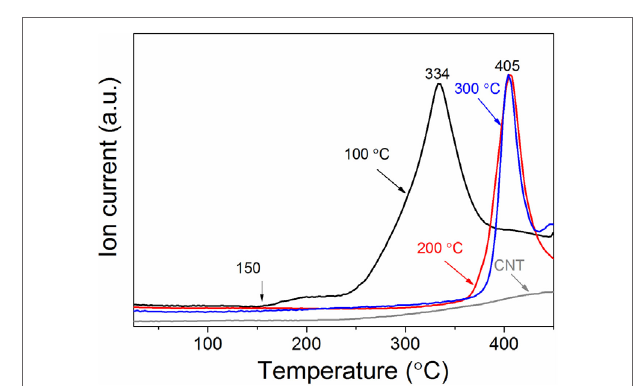
FigUre 3 | X-ray diffraction (XRD) of the magnesium (Mg)/carbon nanotubes (CNTs) composite (CNTs was 2 mg ml –1 ) as function of the hydrogenation temperature.